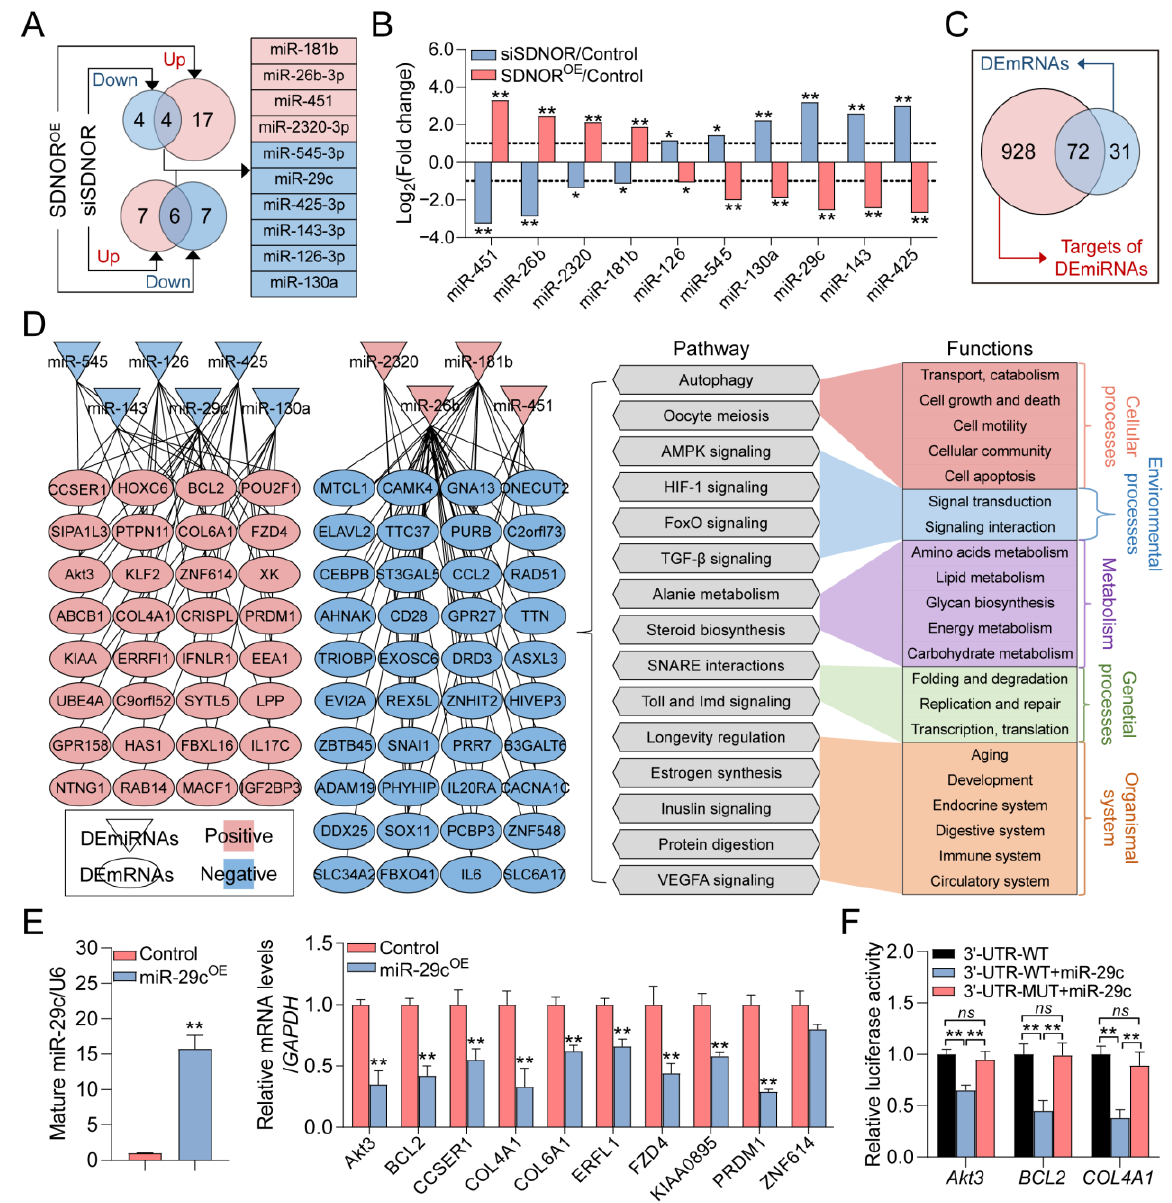
Figure 4. Identification of the SDNOR-mediated DEmiRNA – DEmRNA regulatory network. ( A ) Identification of the SDNOR-regulated DEmiRNAs. The miRNAs in red and blue boxes indicate the positively and negatively regulated DEmiRNAs. ( B ) The expression patterns of SDNOR-regulated DEmiRNAs in GCs after treatment with siSDNOR (blue columns) or SDNOR OE (red columns) were detected by RT-qPCR assays with three independent replicates. y -axis indicates the normalized fold change of DEmiRNAs’ expression levels. ( C ) Venn diagram showing the common genes between DEmRNAs and the targets of DEmiRNAs. ( D ) Identification of the SDNOR-mediated DEmiRNA – DEmRNA regulatory network and pathway – function interactions. The triangles and ovals in the network indicate DEmiRNAs and DEmRNAs. The expression patterns of nodes are shown in red (positive) and blue (negative). The gray hexagons indicate the significantly enriched signal- ing pathways ( p < 0.05). ( E ) The expression alteration patterns of 10 targets in GCs after miR-29c overexpression were detected by RT-qPCR assays. ( F ) Luciferase activity assay. Data in E , F are shown as mean ± S.E.M. with three independent replicates. Significance in B and E was analyzed with a two-tailed Student’s t -test, and in F with ANOVA. * p < 0.05, ** p < 0.01, and ns indicates no